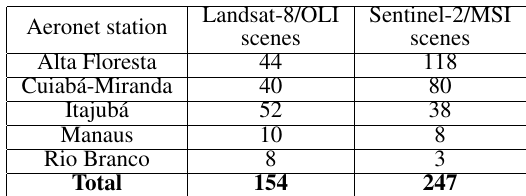
Table 1. Aeronet stations data available considering filter Landsat-8 and Sentinel-2 daily